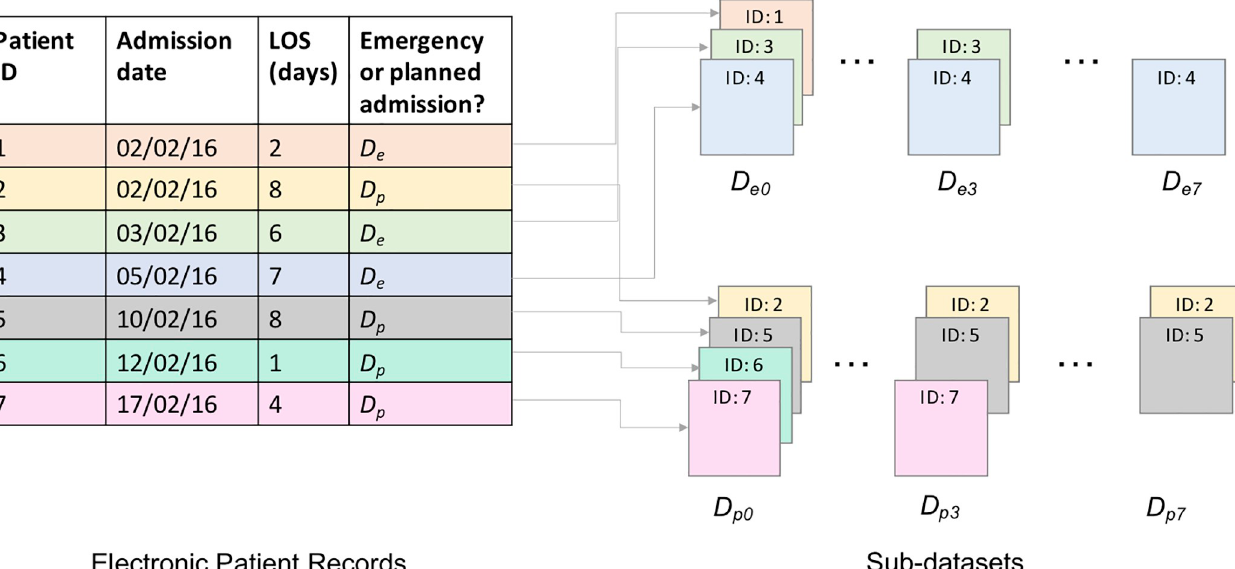
Fig 1. Patient sub-dataset diagram. An illustration of how the sub-datasets were stratified. The figure contains three patients with emergency admissions who had stays that lasted at least 1 day (IDs = 1, 3, 4); at day t = 3 only two of the example patients remained (IDs = 3, 4); and on day t = 7, only one of these patients remained in hospital (ID = 4), therefore we would only be able to make an 8 th day discharge prediction for this remaining patient. A comparable example is also displayed for planned admissions.